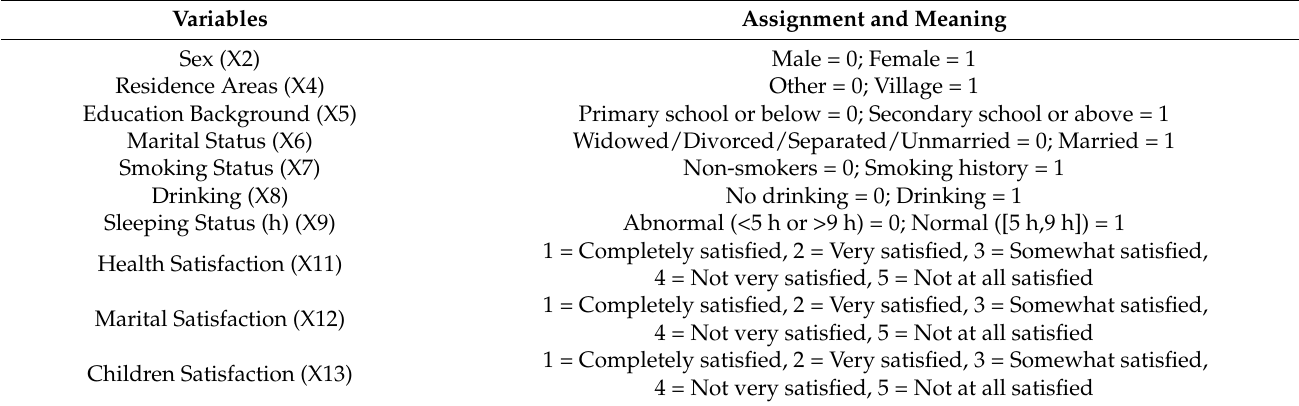
Table 2. Dummy variables assignment.